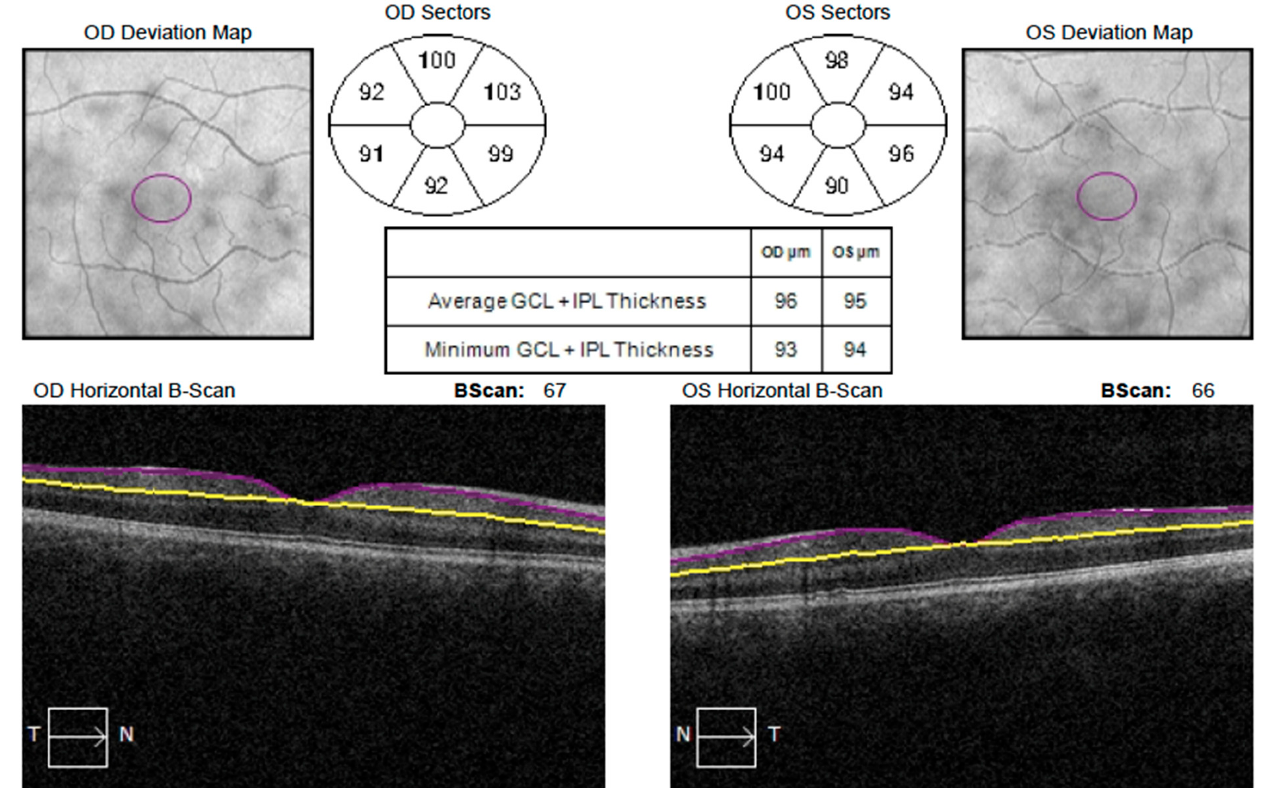
Figure 1. Example of mGCIPL measurement with Cirrus 6000. Visible subdivision into sectors: superior, superonasal, superotemporal, inferior, inferonasal and inferotemporal.